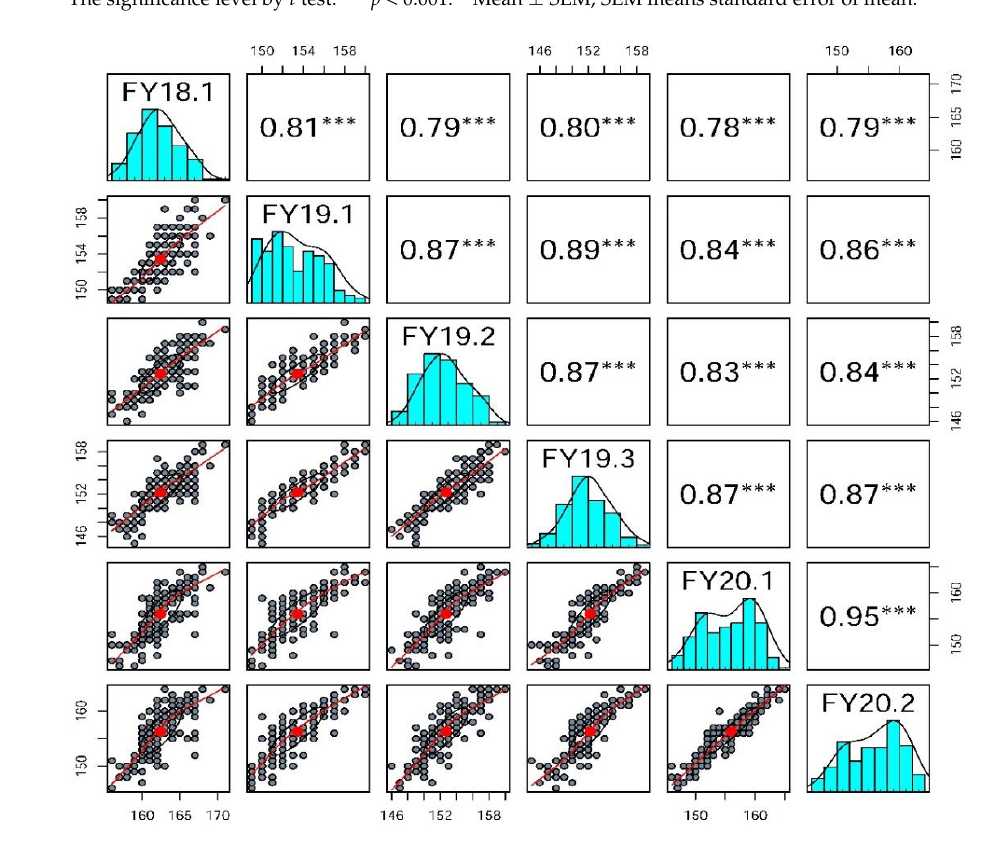
Figure 2. Correlation analyses between days-to-flowering phenotypes of the 158A-SGDH population. Among them, it was repeated once in 2018–2019, three times in 2019–2020, and two times in 2020–2021. *** indicates p < 0.001.